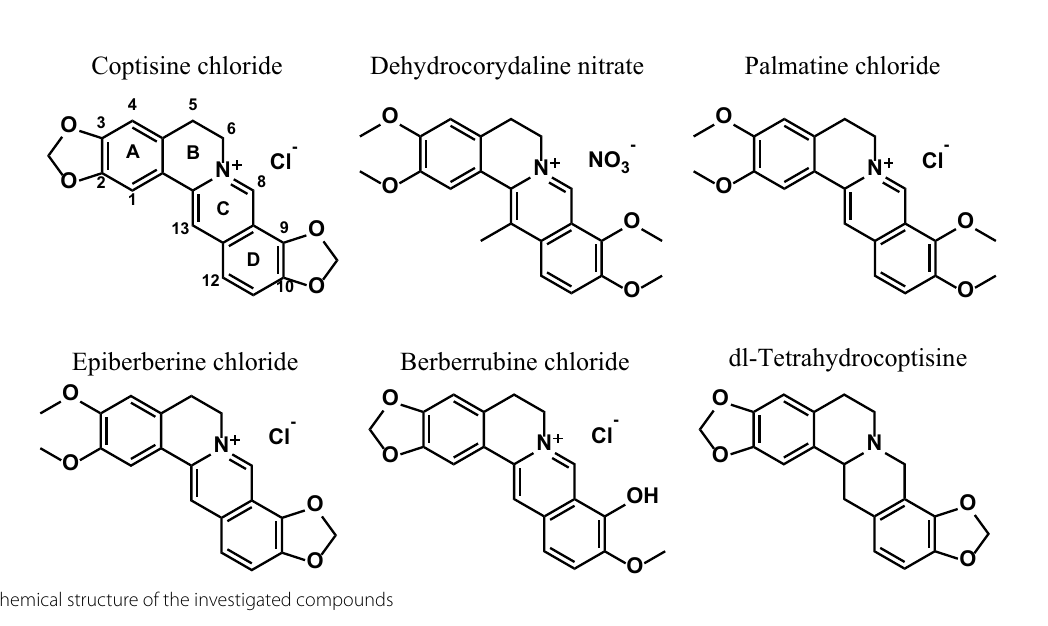
Each experiment was repeated three times and representative data were shown